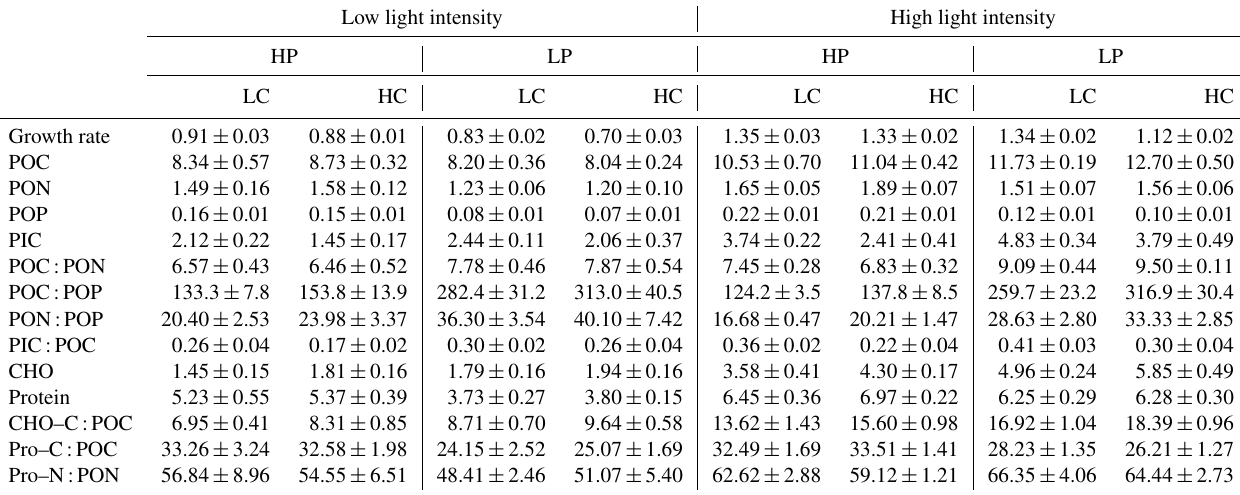
Table 2. Growth rate (d − 1 ) ; cellular contents of POC, PON, POP, PIC, carbohydrate (CHO), and protein (Pro) (pgcell − 1 ) ; the ratios of POC : PON, POC : POP, PON : POP, and PIC : POC; the percentages of POC allocated to carbohydrate (CHO–C : POC) and protein (Pro– C : POC); and the percentage of PON allocated to protein (Pro–N : PON) (%). LC and HC represent low CO 2 (426µatm) and high CO 2 (946µatm) levels, respectively. Please see Table 1 for more detailed